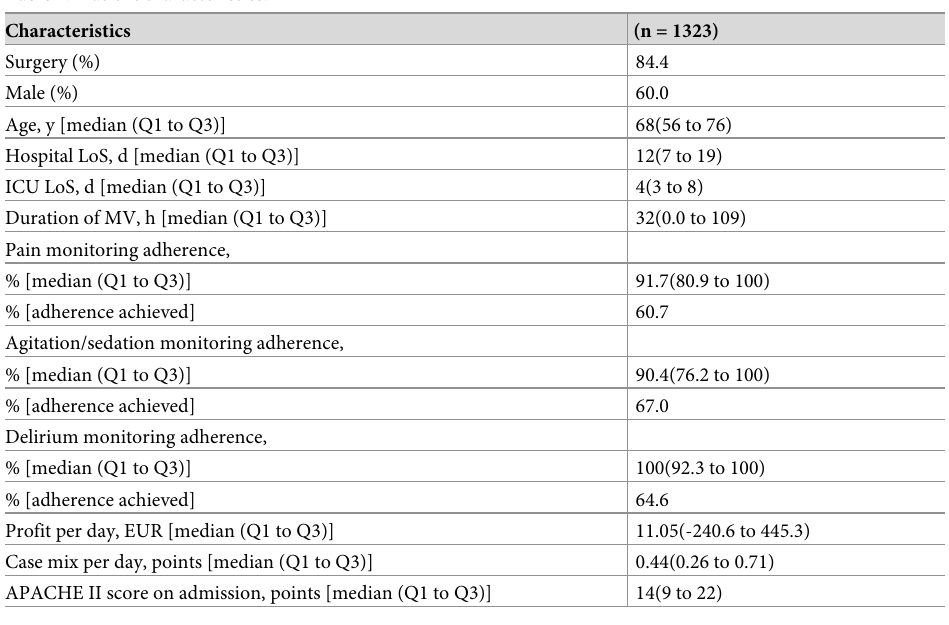
Table 1. Patient